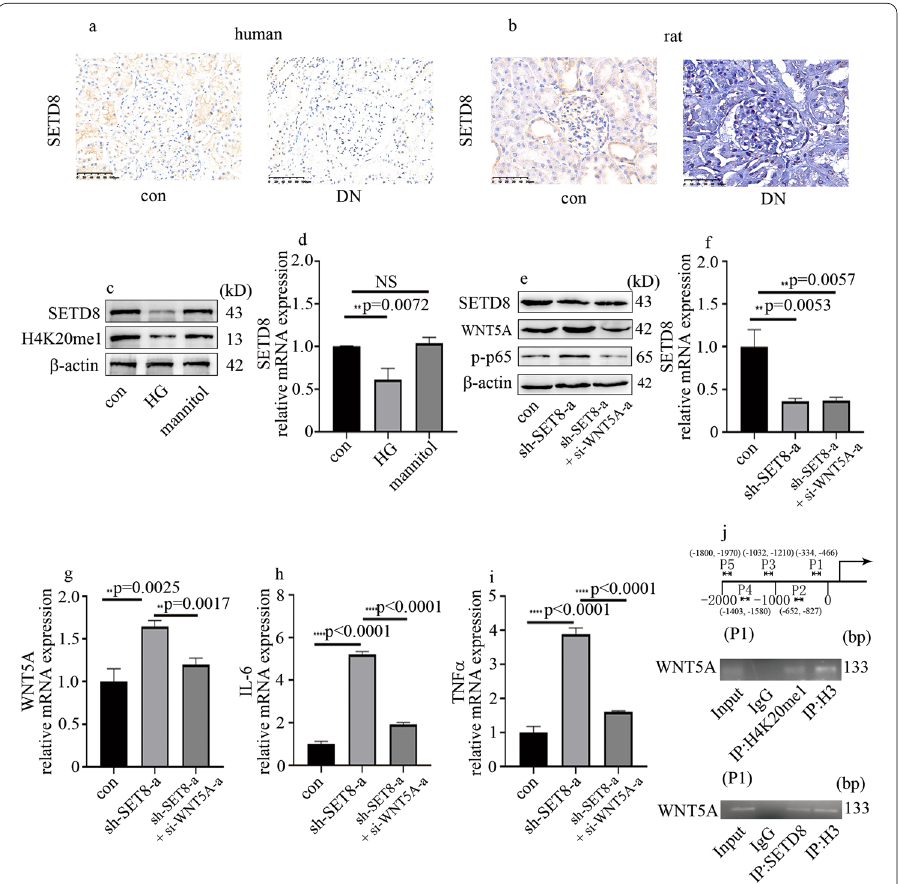
Fig. 3 SETD8 was involved in high-glucose-induced p-p65 and inflammatory factors levels through modulation of WNT5A levels in HGECs. a , b IHC expression of SETD8 in human and rat. c Western blot analysis of SETD8 and H4K20mel in HGECs. d mRNA expression of SETD8 in HGECs. e Western blot analysis of SETD8, WNT5A, and p-p65 in HGECs. f – i mRNA expression of SETD8, WNT5A, IL-6, and TNFα in HGECs. j SETD8 and H4K20mel were enriched in the WNT5A promoter (* p < 0.05, ** p < 0.01, *** p < 0.001, **** p < 0.0001, n